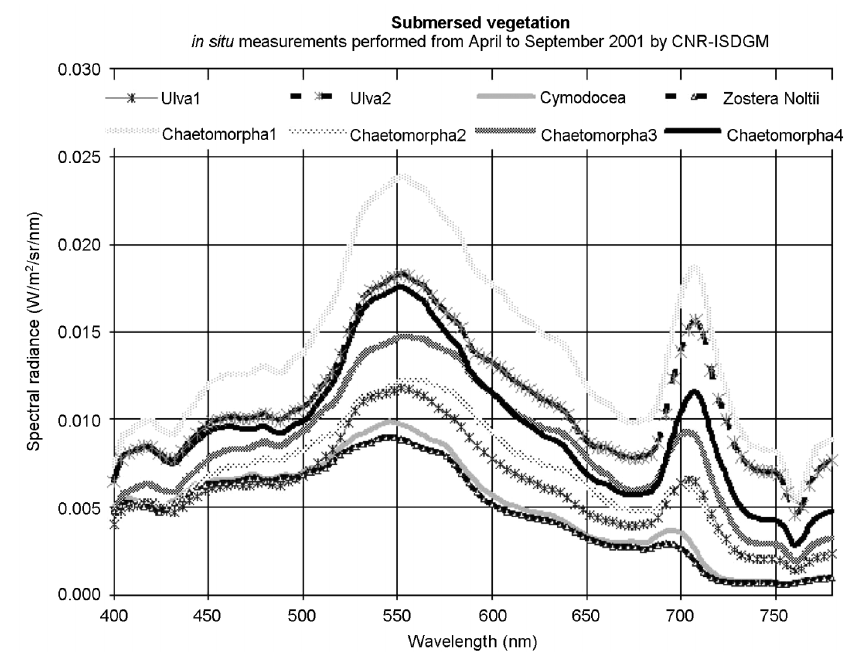
Fig. 1. Spectral radiance mean values of some submersed vegetation